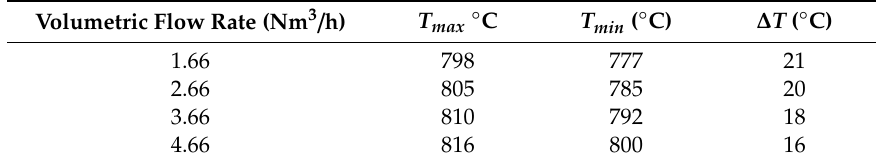
Figure 12. The e ff ect of di ff erent hydrogen flow rates on the temperature of strip. Gas inlet and outlet Figure 12. The effect of different hydrogen flow rates on the temperature of strip. Gas inlet and outlet position: Figure 10b, Strip velocity = v Strip ( < 0.17 m/s ) . position: Figure 10b, Strip velocity = 𝑣 𝑆𝑡𝑟𝑖𝑝 (< 0.17 m/s) . Table 3. Temperature values resulted from the di ff erent volumetric hydrogen flow rates at the Table 3. Temperature values resulted from the different volumetric hydrogen flow rates at the specific specific position.